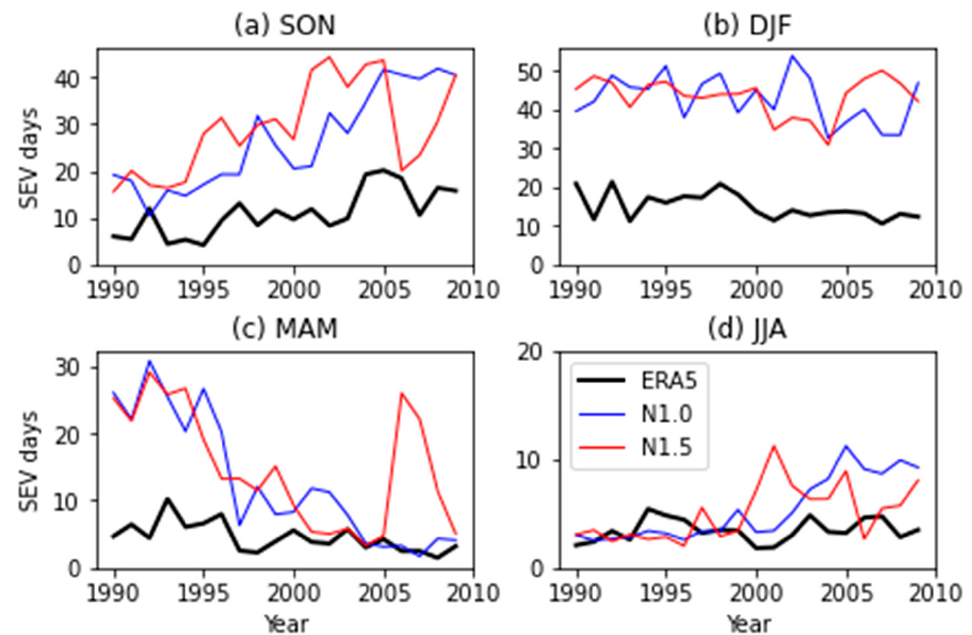
Figure A22. Interannual time series during 1990–2009 of the number of days with severe thunder- storm potential for ( a ) Spring, ( b ) Summer, ( c ) Autumn and ( d ) Winter from the land grid points of the d02 domain of ERA5 (black line), N1.0 (blue line) and N1.5 (red line).